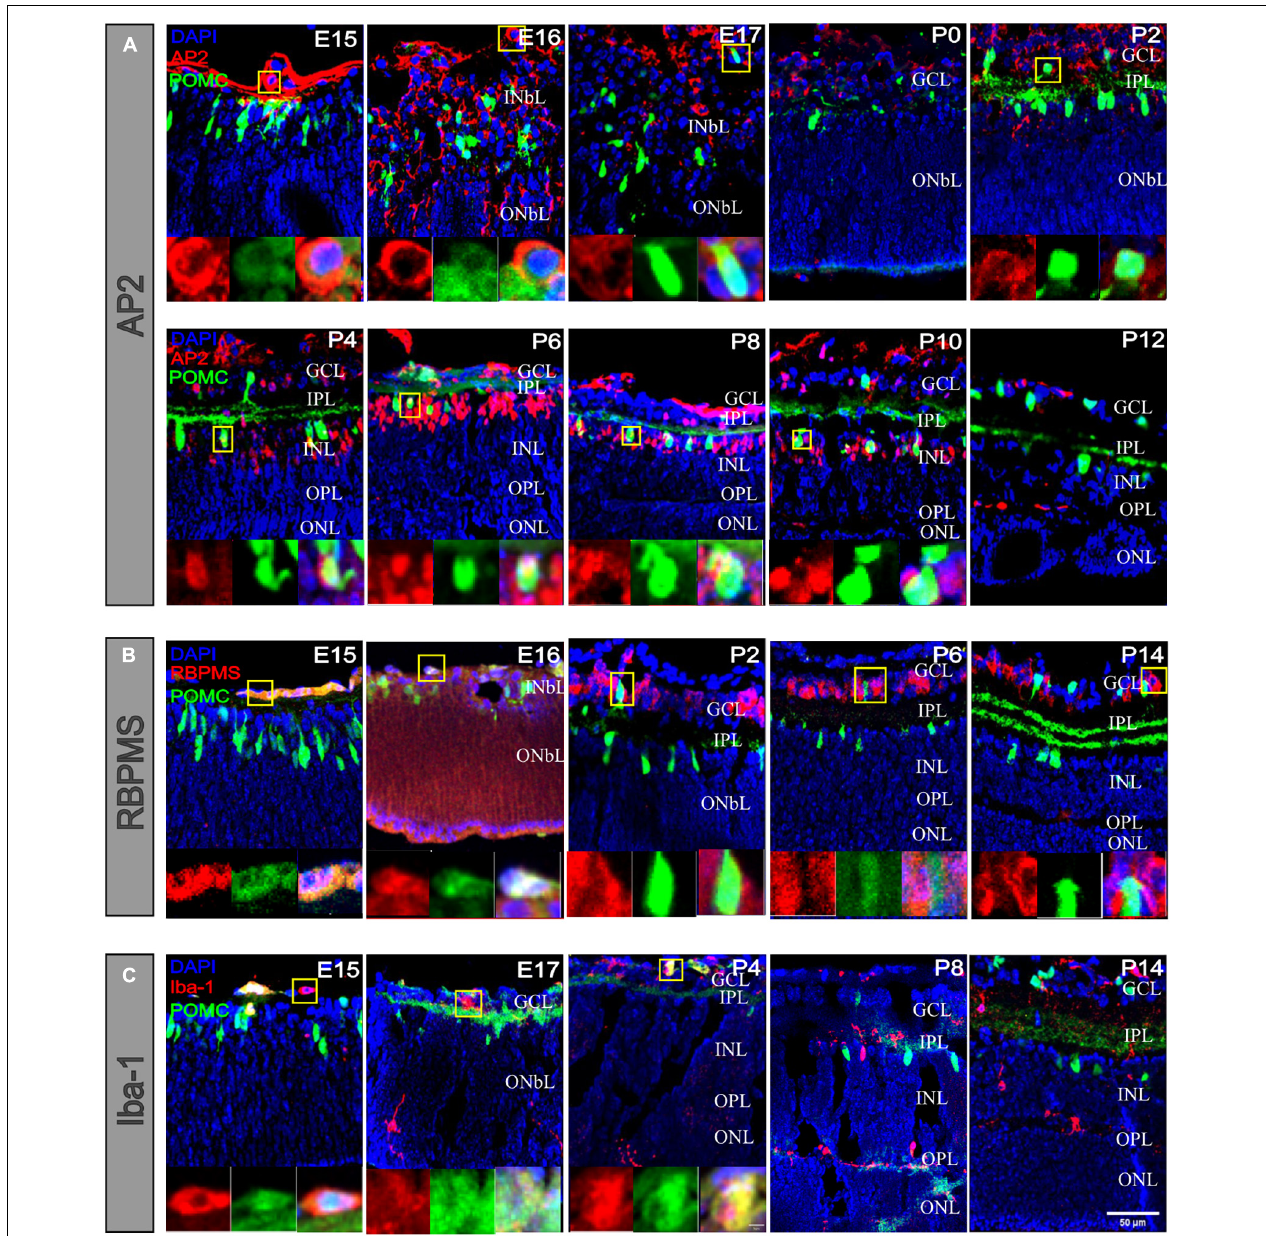
FIGURE 7 | POMC-positive cells costained with RGCs and microglial cells at early developmental stages. (A) POMC-positive cell costaining with AP2 (red). There were merged cells at different stages. At the open-eye stage, AP2-positive cells were smaller than POMC-positive cells. Before P2, merged cells were always located on the basal side, whereas after P2, merged cells appeared in the INL. (B) POMC-positive cell co-staining with RBPMS (red). There were merged cells at E15 and E16 on the basal side, and in the later stage, there were no prominent merged cells. (C) POMC-positive cell costaining with Iba-1 (red). There were also merged cells on the basal side at early stages, such as E15, E17, and P4. With the development of the IPL and OPL, microglia migrated to the outer retina, and no cells merged left. Each image on the bottom is an enlarged image of cells in the yellow boxes. Bar = 50 µ m for the large images and 5 µ m for the enlarged pictures ( n = 4 for each time point and each